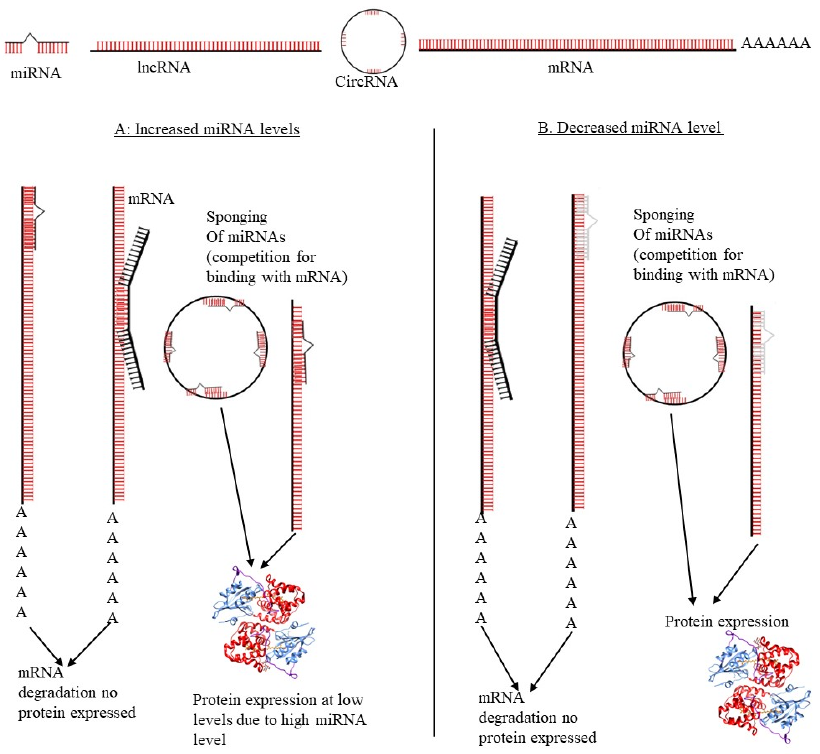
Figure 3. ceRNA network regulation in cervical cancer. mRNAs compete with lncRNAs and circRNAs for miRNA binding. ( A ) When upregulated, miRNAs bind to the 3’ UTR of mRNA and inhibit translation. However, this depends on the sponging ability of lncRNAs and circ-RNAs. ( B ) The down-regulation of miRNAs may promote protein translation from various transcripts (lncRNA, mRNA, and circRNA).